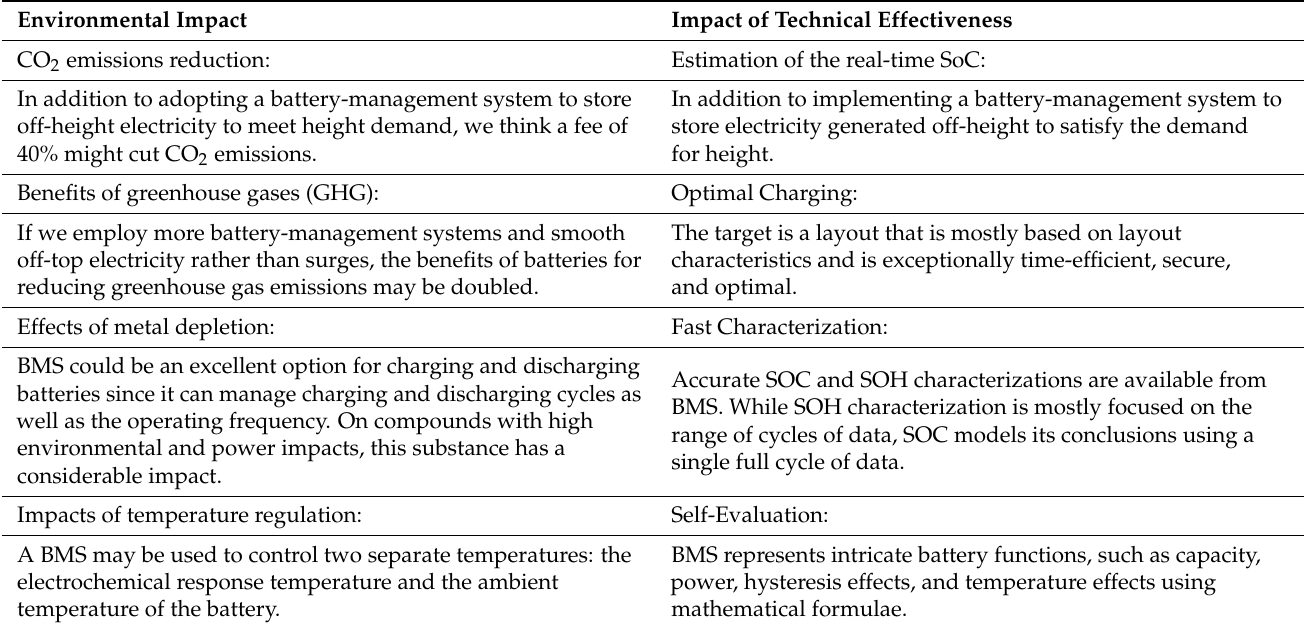
Table 1. Environmental and technical efficiency impact of battery-management